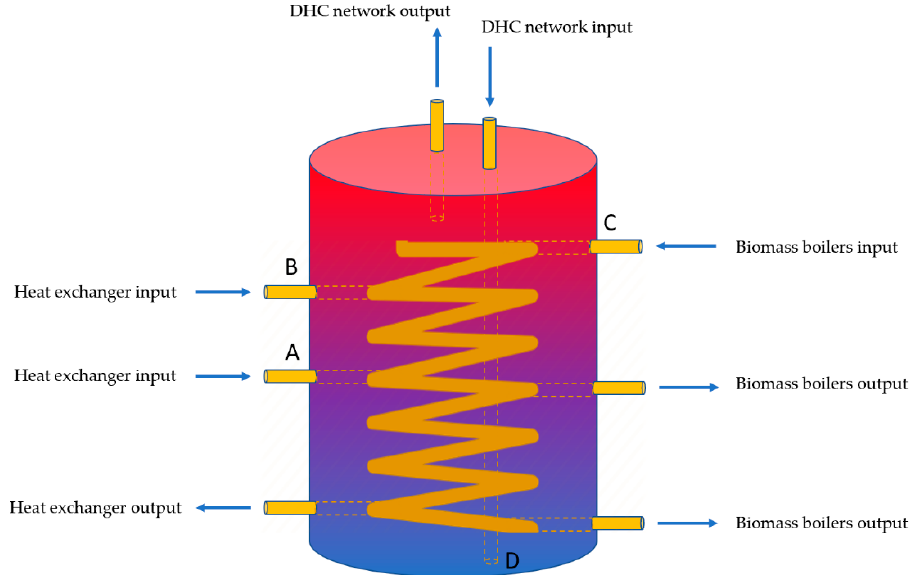
Figure 3. Schematic of the colloidal pipes and the basic structure of the heat storage tank.